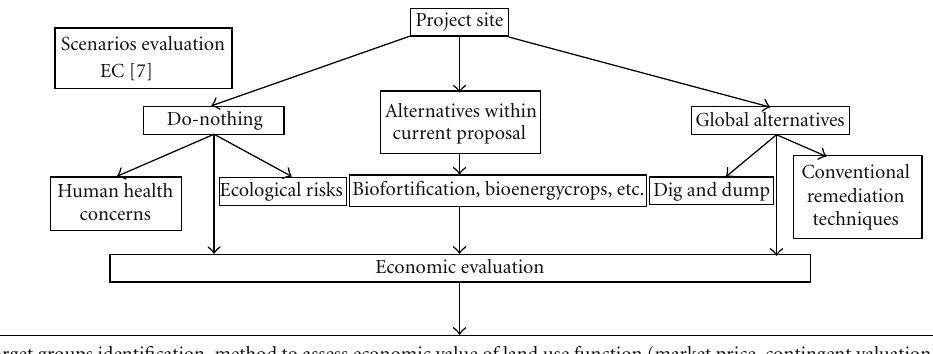
Figure 3: Scheme of evaluation steps in a project remediation